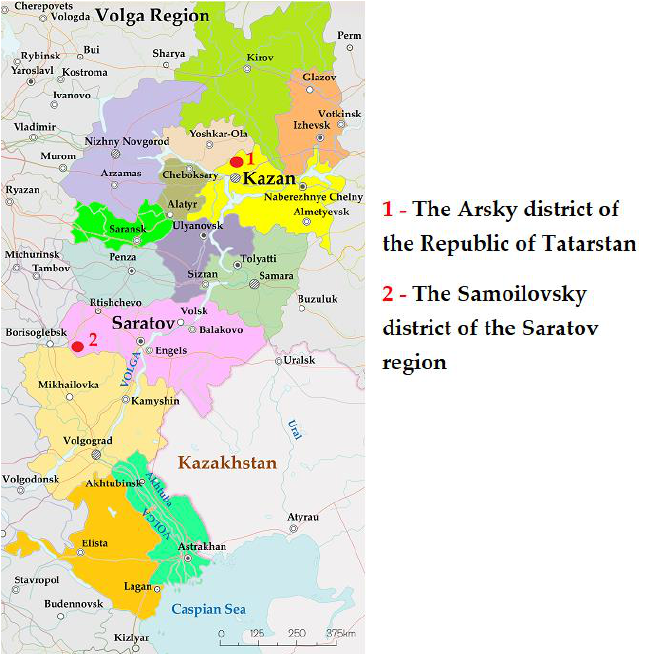
Figure 1. Map of the Volga region that shows areas where pathogen populations were collected (marked with a red circle); original maps taken from Fedorov E.E. https://fedoroff.net/ (accessed on 06 March 2023).